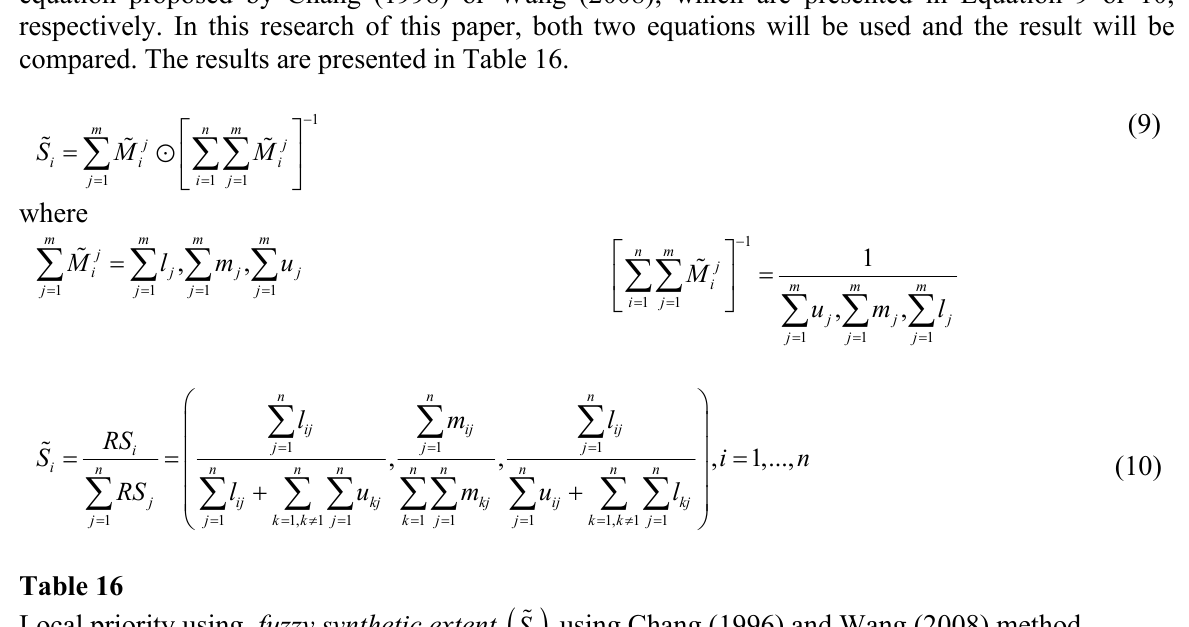
Local priority using fuzzy synthetic extent  using Chang (1996) and Wang (2008) method